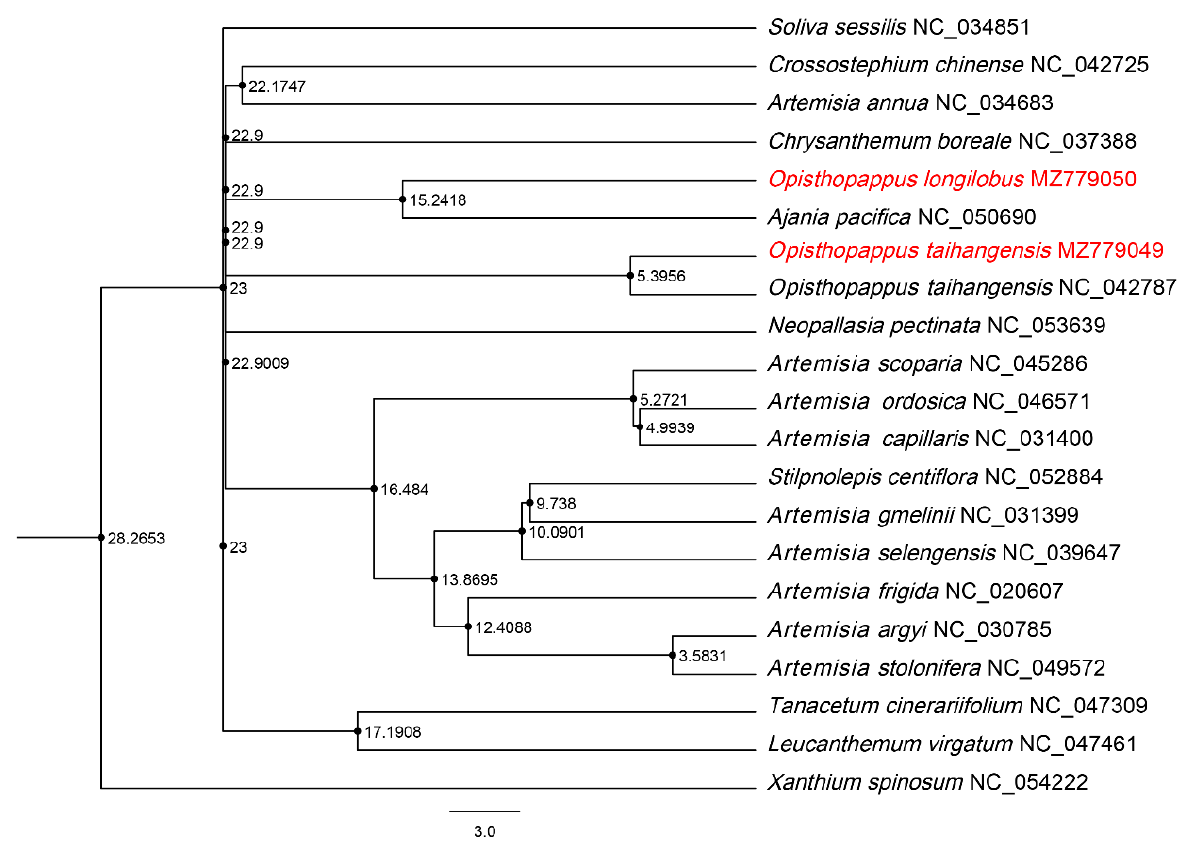
Figure 4. Maximum likelihood (ML) phylogenetic tree based on chloroplast genomes of subtribe Chrysantheminae. The top left corner shows a comparison of the habitat maps of the two species.